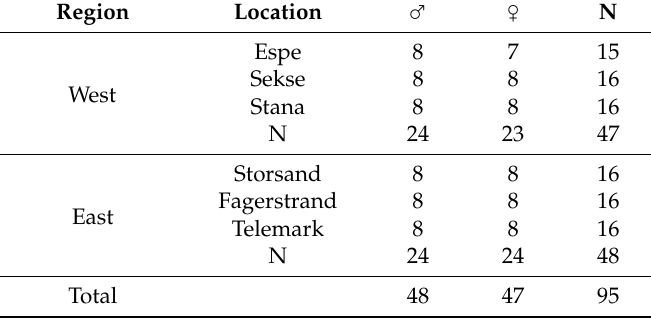
Figure 1. The geographical locations of the sampling areas (blue dots; the size of the dot relative to the size of the sampling area). Table 1. Overview of A. conjugella samples from Southern Norway, n = is the number individuals. Region